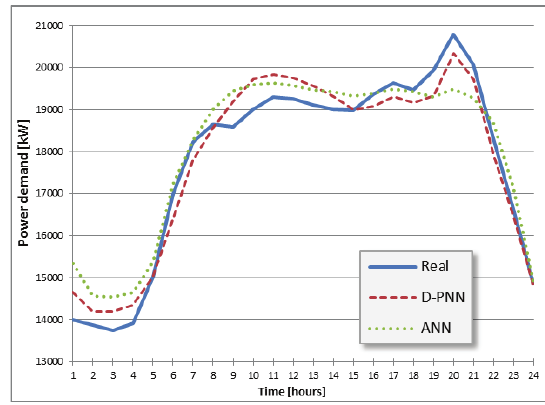
Fig. 15. IESO : 23.4.2012 (Monday). D-PNN RMSE = 430.1 , ANN RMSE = 598.6